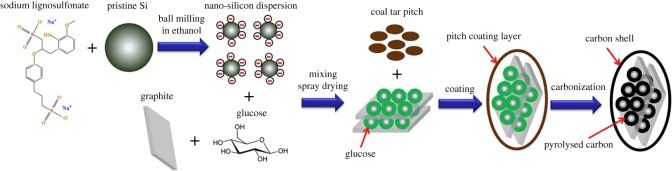
Schematic illustration of the synthesis procedures of G/Si@C [77].